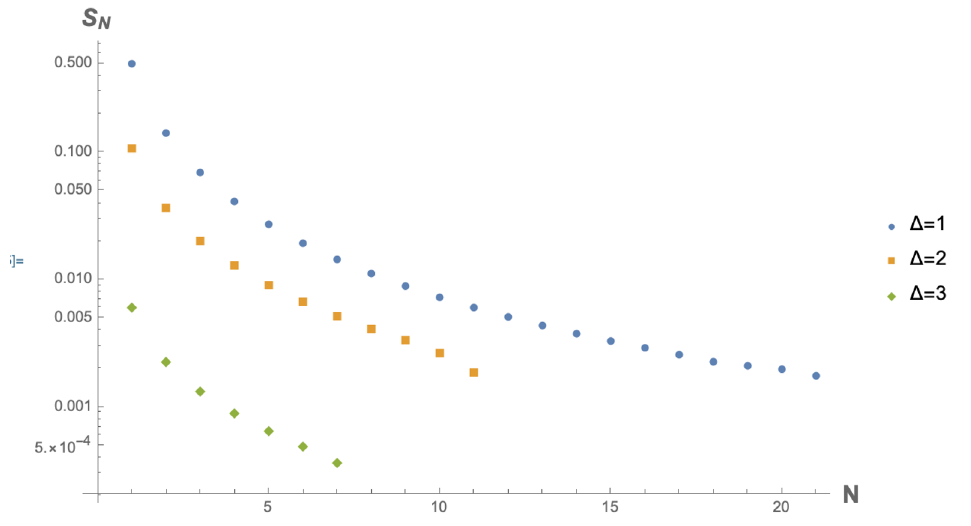
Figure 4 . Sum rule applied for the L = 1 case for ∆ φ = 1 , 2 , 3 , truncated after summing over N terms seen on a logarithmic scale. The slower convergence compared to L = 0 is to be expected from the worse Regge